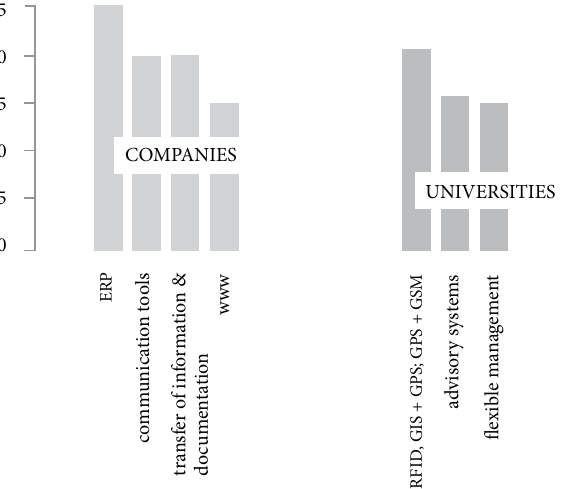
Fig. 5. Present requirements on IT tools by Polish building companies and academics